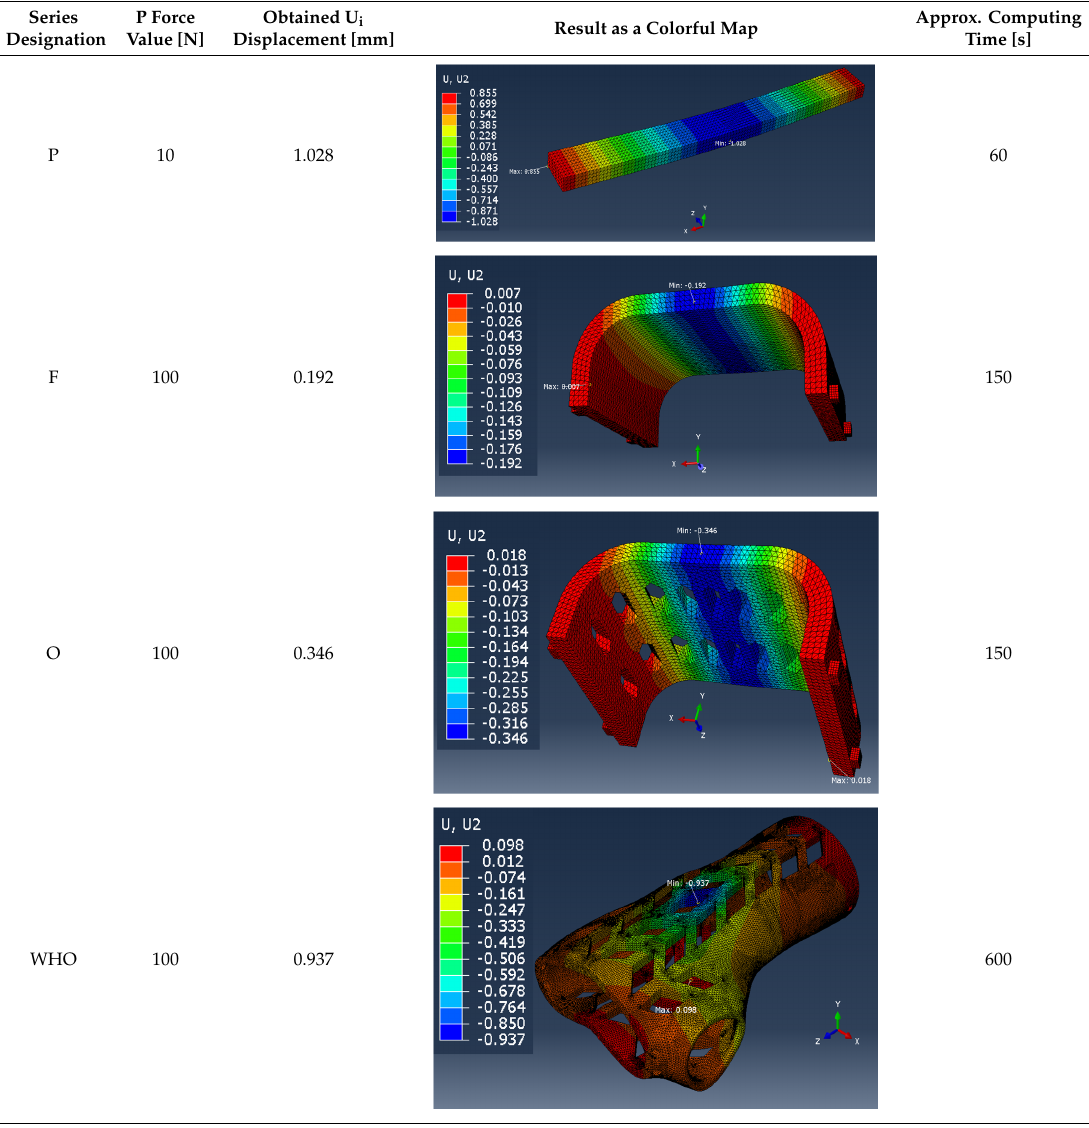
Table 5. U 2 vertical displacement for all sample series.